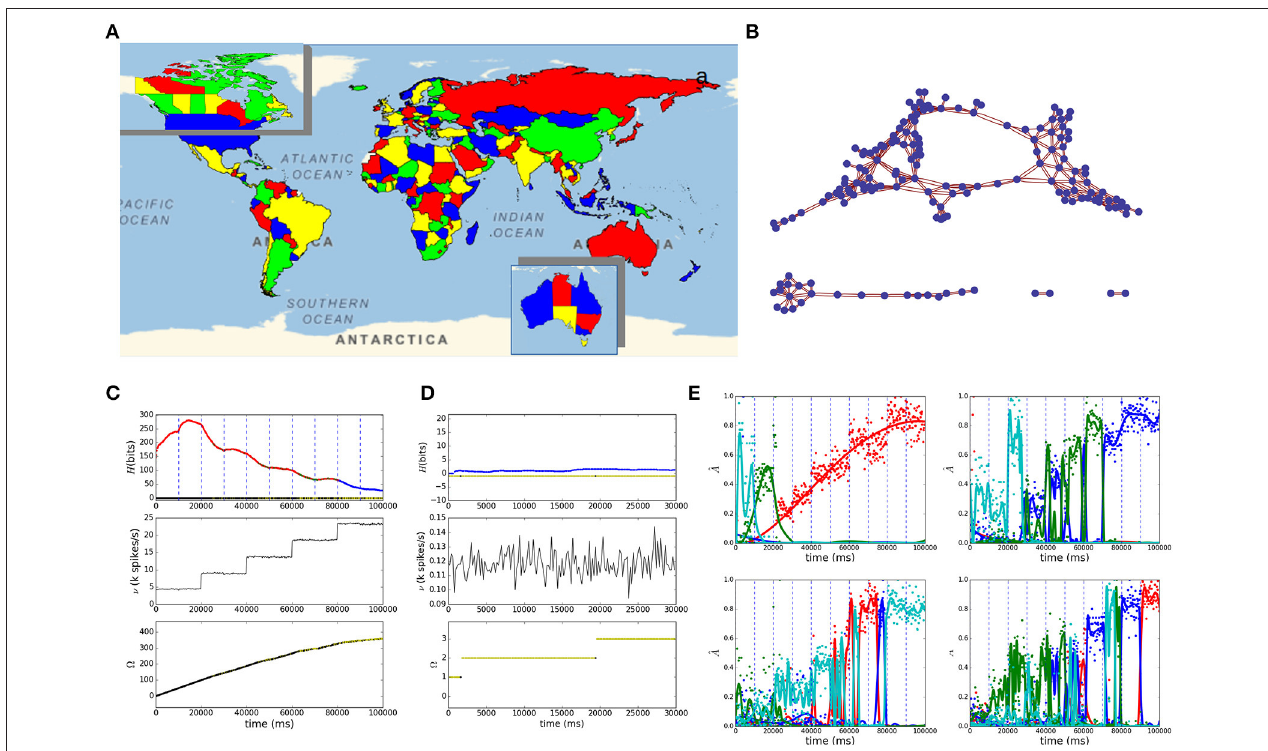
FIGURE 1 | (A) Solution to the map coloring problem of the world with four colors and of Australia and Canada with three colors (insets). (B) shows the graph of bordering countries from (A) . The plots of the entropy H (top), mean firing spike rate ν (middle), and states count (cid:127) (bottom) v.s. simulation time are shown in (C,D) for the world and Australia maps, evidencing the convergence of the network to satisfying stationary distributions. In the entropy curve red codes for changes of state between successive time bins, green for no change and blue for the network satisfying the CSP. In the states count line, black dots mean exploration of new states; the dots are yellow if the network returns to states visited before. In (E) we have plotted the population activity for four randomly chosen CSP variables from (A) , each line represents a color